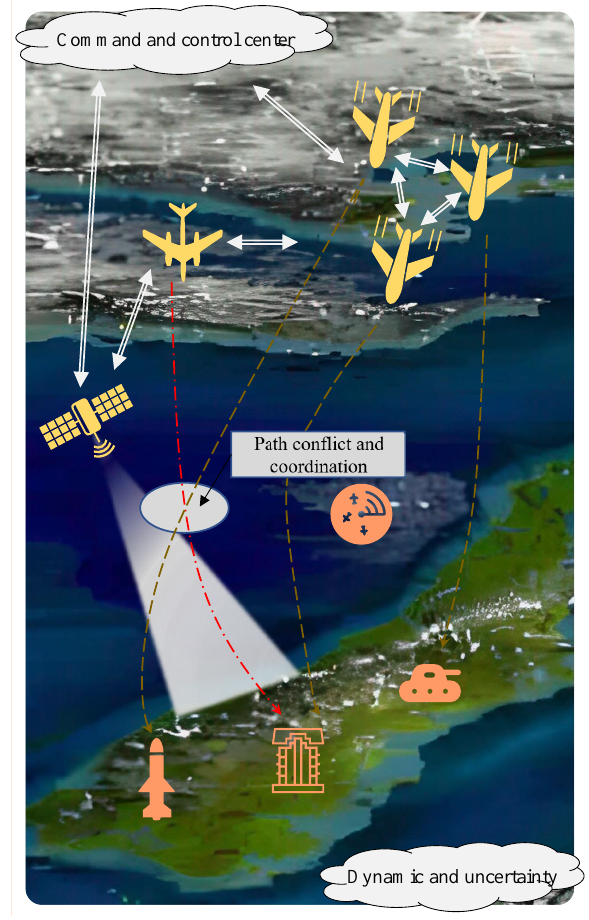
Figure 1. A typical Multi-UAV combat